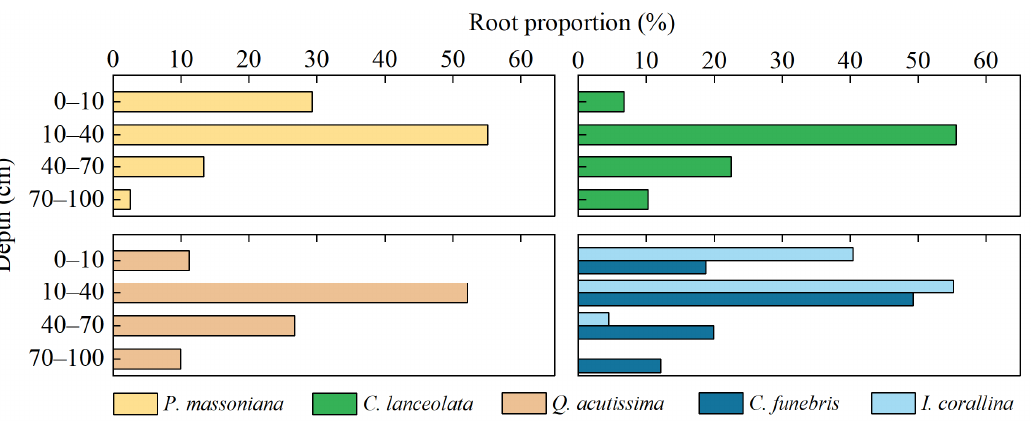
Figure 10. Vertical distribution of root biomass of the plant species in the four plots.